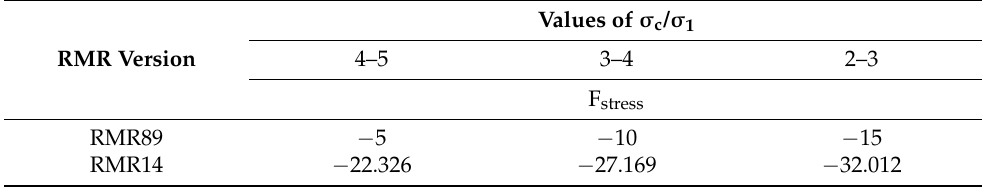
Figure 11. Procedure for determining F stress in RMR 14 , while considering the five cases listed in Table 6 (modified after [32,72]). Table 7. F stress based on strength–stress ratio for the two versions of rock mass